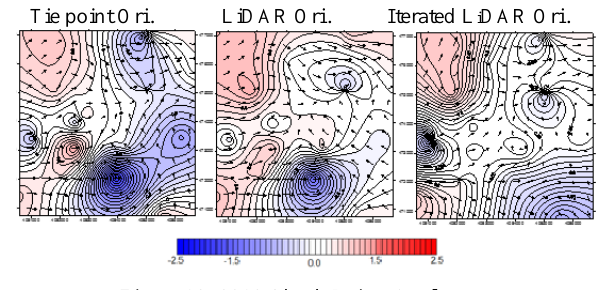
Figure 12: 2010 Check Points Analyse Studying discrepancies in planimetric coordinates, the point errors evolves from 0.537 m in the tie point orientation phase to 0.502 m. at the end of the proposed methodology. On the other hand, the altimetric error evolves from 0.032 meters to 0.023 m. XYZ Error [m.]